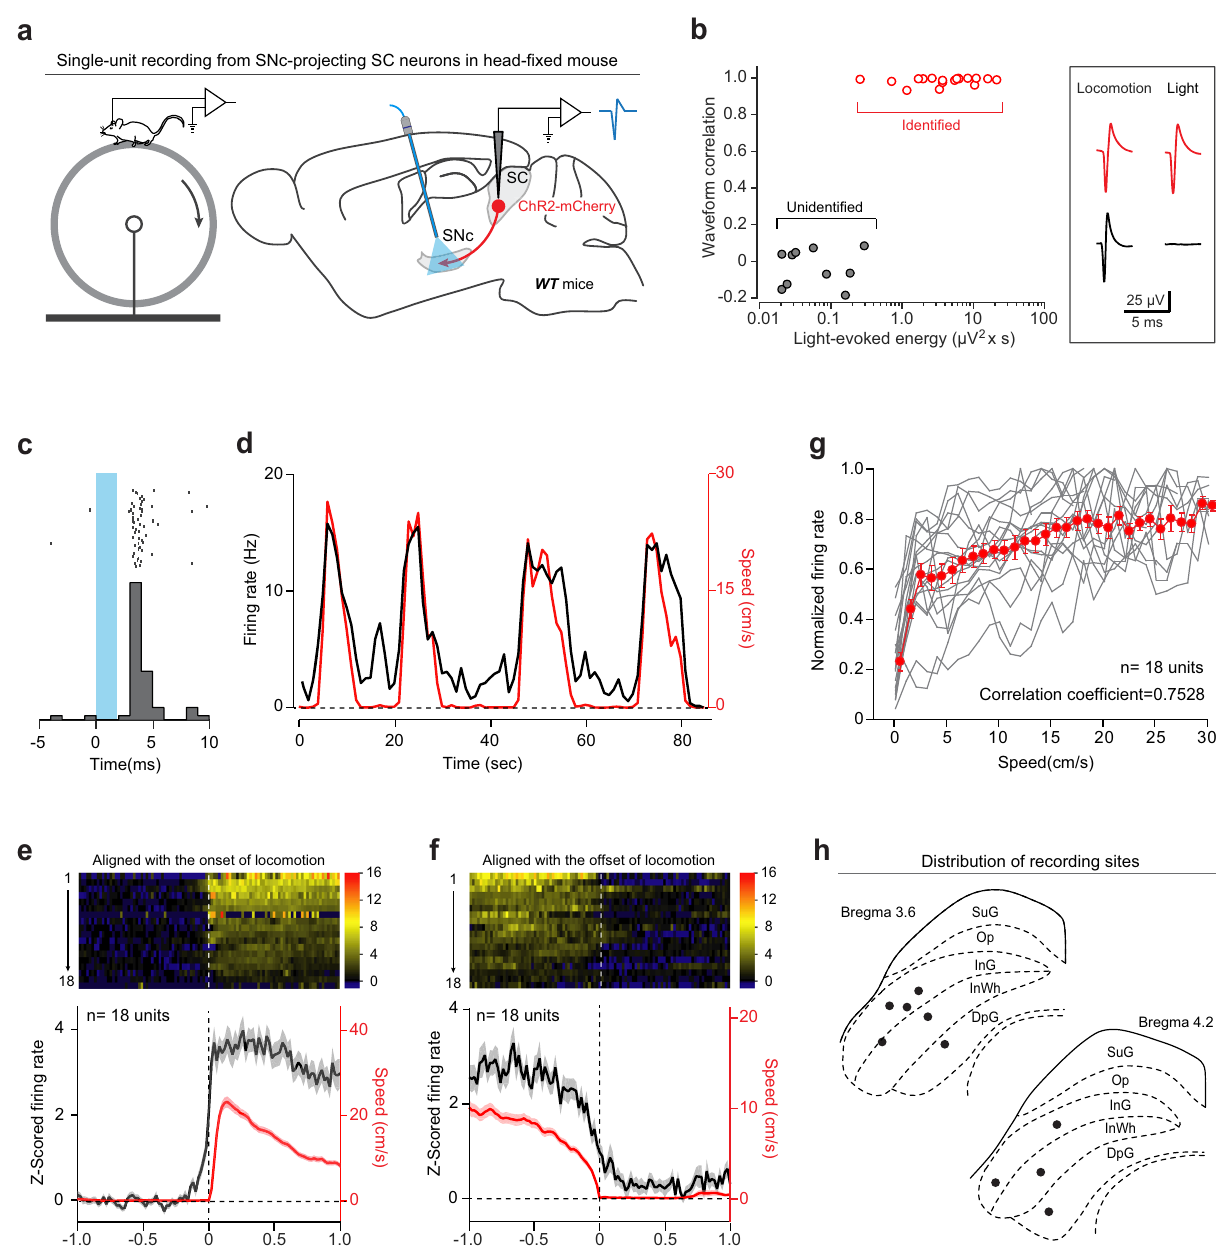
Fig. 4 SNc-projecting SC neurons encode locomotion speed. a Schematic diagram showing a head- fi xed awake mouse walking on a cylindrical treadmill (left) and antidromic activation strategy for single-unit recording from SNc-projecting SC neurons (right). b Correlation analysis of action potentials of individual units evoked either by light pulses (Light) or by locomotion (Locomotion), con fi rming a segregation between antidromically identi fi ed units (red dots and traces) and unidenti fi ed units (gray dots and traces). c Raster (top) and peristimulus time histogram (PSTH, bottom) of an example putative SNc-projecting SC neurons showing a latency of ~3 ms relative to the onset of light pulses. d Smoothed PSTH (trace in black) of an example putative SNc- projecting SC neuron aligned with locomotion speed (trace in red). e , f Heat-map graphs (top) and averaged time course (bottom) of Z -scored fi ring rate of 18 putative SNc-projecting SC neurons aligned to the onset ( e ) and the offset ( f ) of locomotion. g Averaged (red) and individual (gray) normalized instantaneous fi ring rate during locomotion as a function of locomotion speed in 500 ms bins. h Distribution of recording site (black dots) in the SC. Number of units was indicated in the graphs ( e – g ). Data in e – g are means ± SEM (error assessed by measuring the speed of approach and frequency of predatory hunting, appetitive locomotion occurred when pre- approach. The speed of approach was calculated by averaging the dator approached prey (Fig. 6c). By measuring the instantaneous peak speed of each approach episode in the trial. The frequency of azimuth angle and distance between prey and predator approach was the number of approach episodes divided by total (Supplementary Fig. 8b), we were able to identify a series of time of the trial. With the method above, we labeled the approach intermittent approach episodes (Supplementary Fig. 8c, shaded episodes (shaded areas in orange) in the behavioral ethogram of areas in orange) according to the established criteria 3 . Appetitive locomotion in these approach episodes was quantitatively predatory hunting in mice without (Ctrl) and with (TeNT)